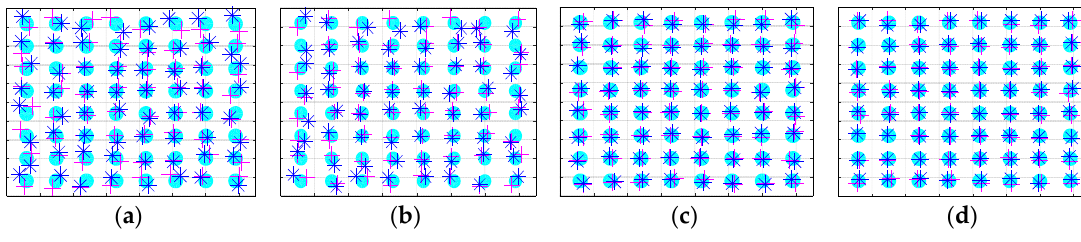
Figure 8. Gaze point estimation with/without considering error compensation: ( a ) gaze point estimation utilizing a four ‐ marker calibration model; ( b ) gaze point estimation utilizing a six ‐ marker calibration model; ( c ) gaze point estimation utilizing a nine ‐ marker calibration model; ( d ) gaze point estimation utilizing a 16 ‐ marker calibration model.